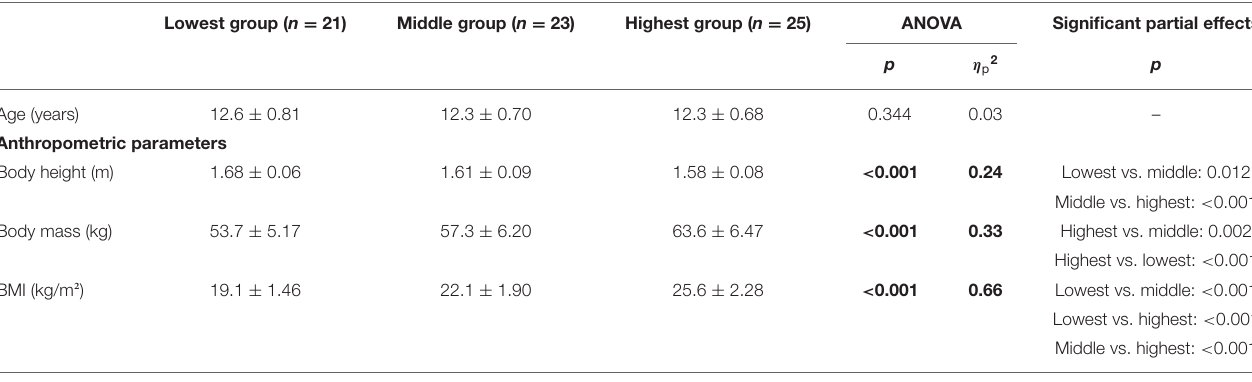
TABLE 2 | Comparison of age and anthropometric characteristics between three groups.